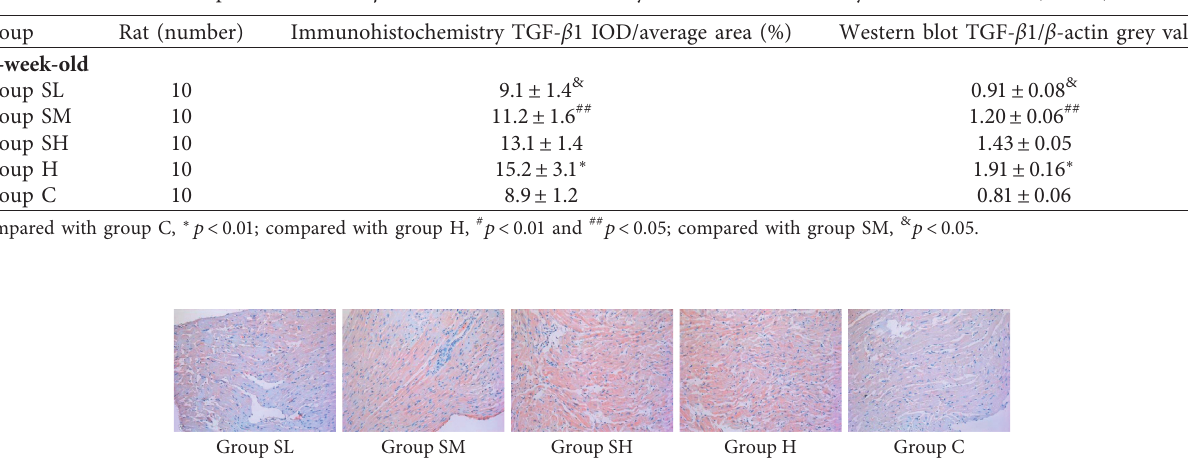
Figure 3: Immunohistochemical staining of TGF- β 1 in atrial